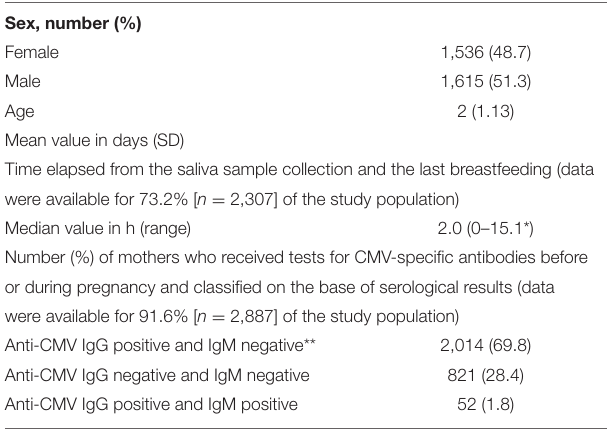
TABLE 1 | Baseline characteristics of the study population at the time of